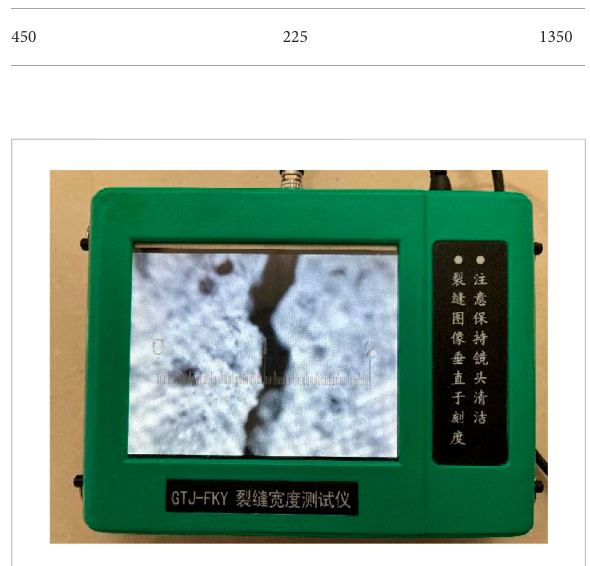
FIGURE 1 Schematic diagram of crack width measurement using GTJ- FKY crack width